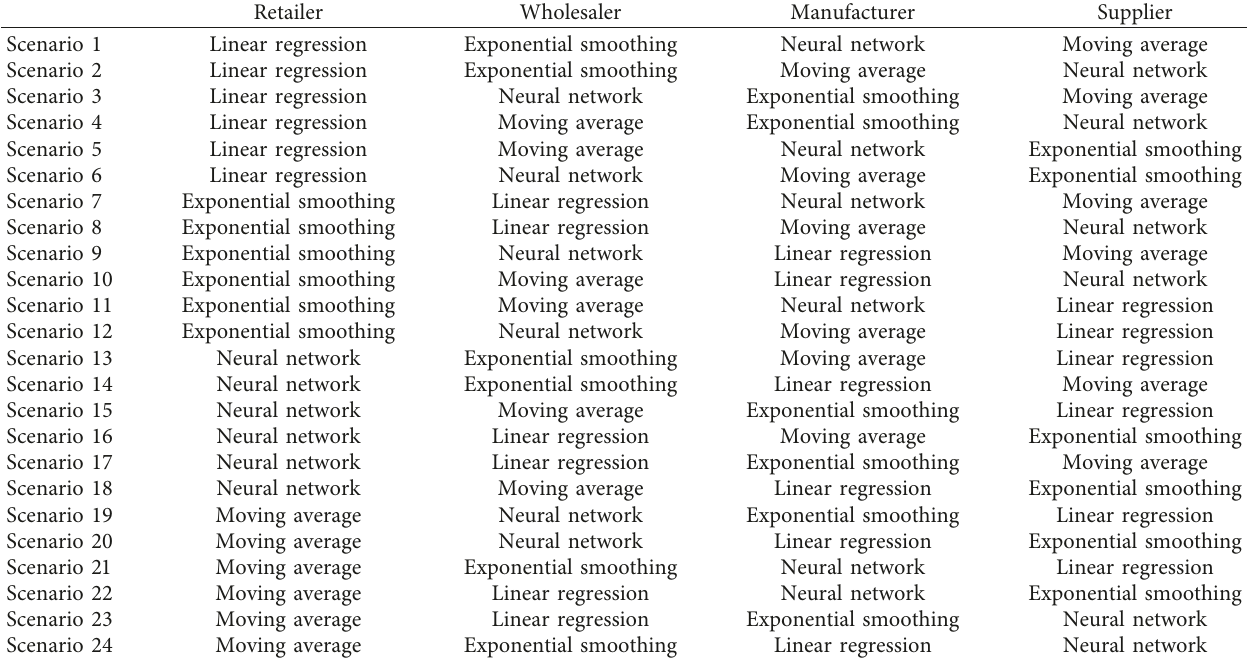
Table 2: Scenarios of forecasting methods in the four-level supply